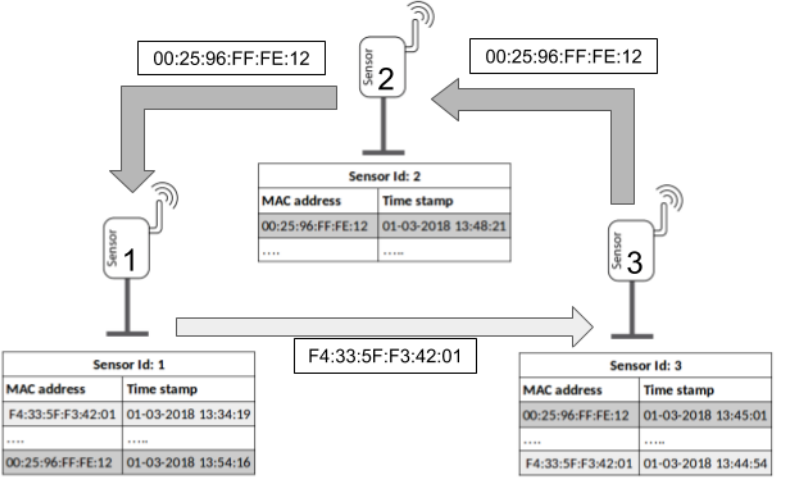
Figure 1. Global view of the